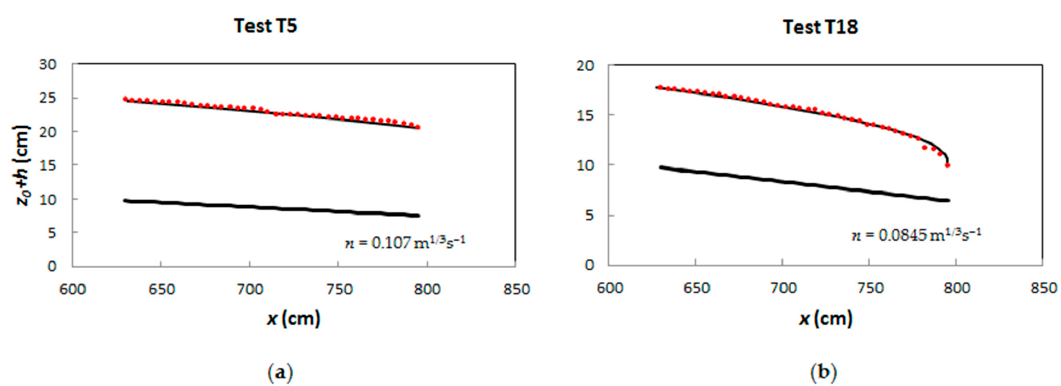
Figure 6. Comparison between the measured and the calculated free surface profiles obtained by means of the best Manning coefficient: ( a ) T5; ( b ) T18. The black bold line indicates the flume bottom; the black line is the calculated free surface; the red symbols indicate the measured free surface. In this way, we obtained a continuous line representing the free surface profile and the 𝐽 values for each abscissa. The 𝐶 (cid:3005) experimental values, here identified as 𝐶 (cid:3005)(cid:2879)(cid:3041) , were computed by means of Equation (9) and, when plotted versus 𝑅𝑒 (cid:3005)∗ , they appear as in Figure 7.